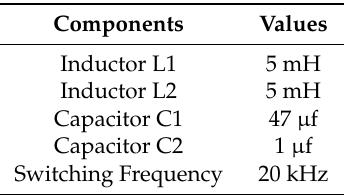
Table 2. Parameters of the selected DC-DC converter components.